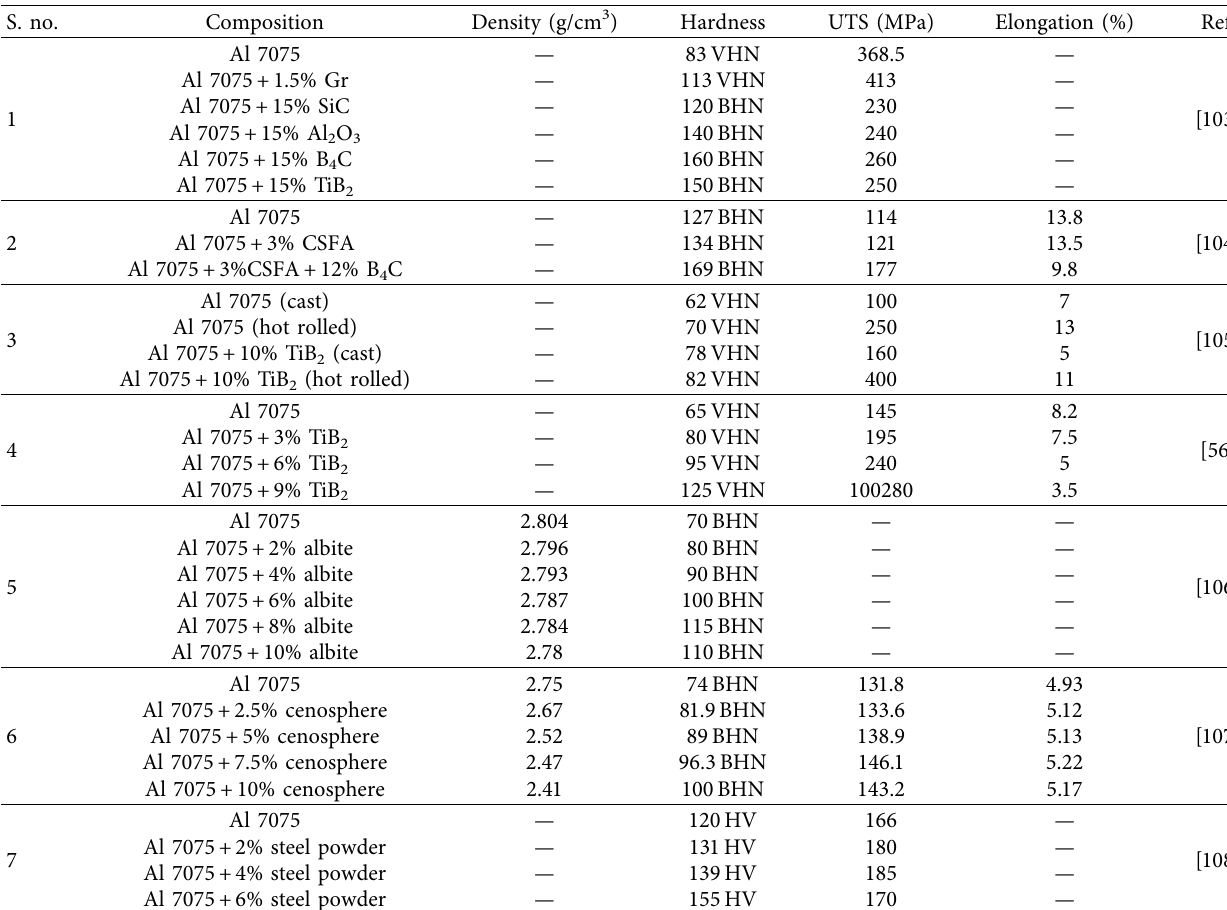
Table 7: Mechanical properties of Al 7075